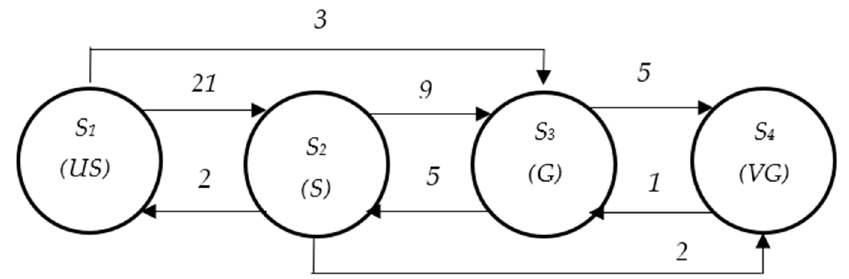
Figure 3. Graph of the development states of employees of the sanatorium-resort complex in Truskavets.